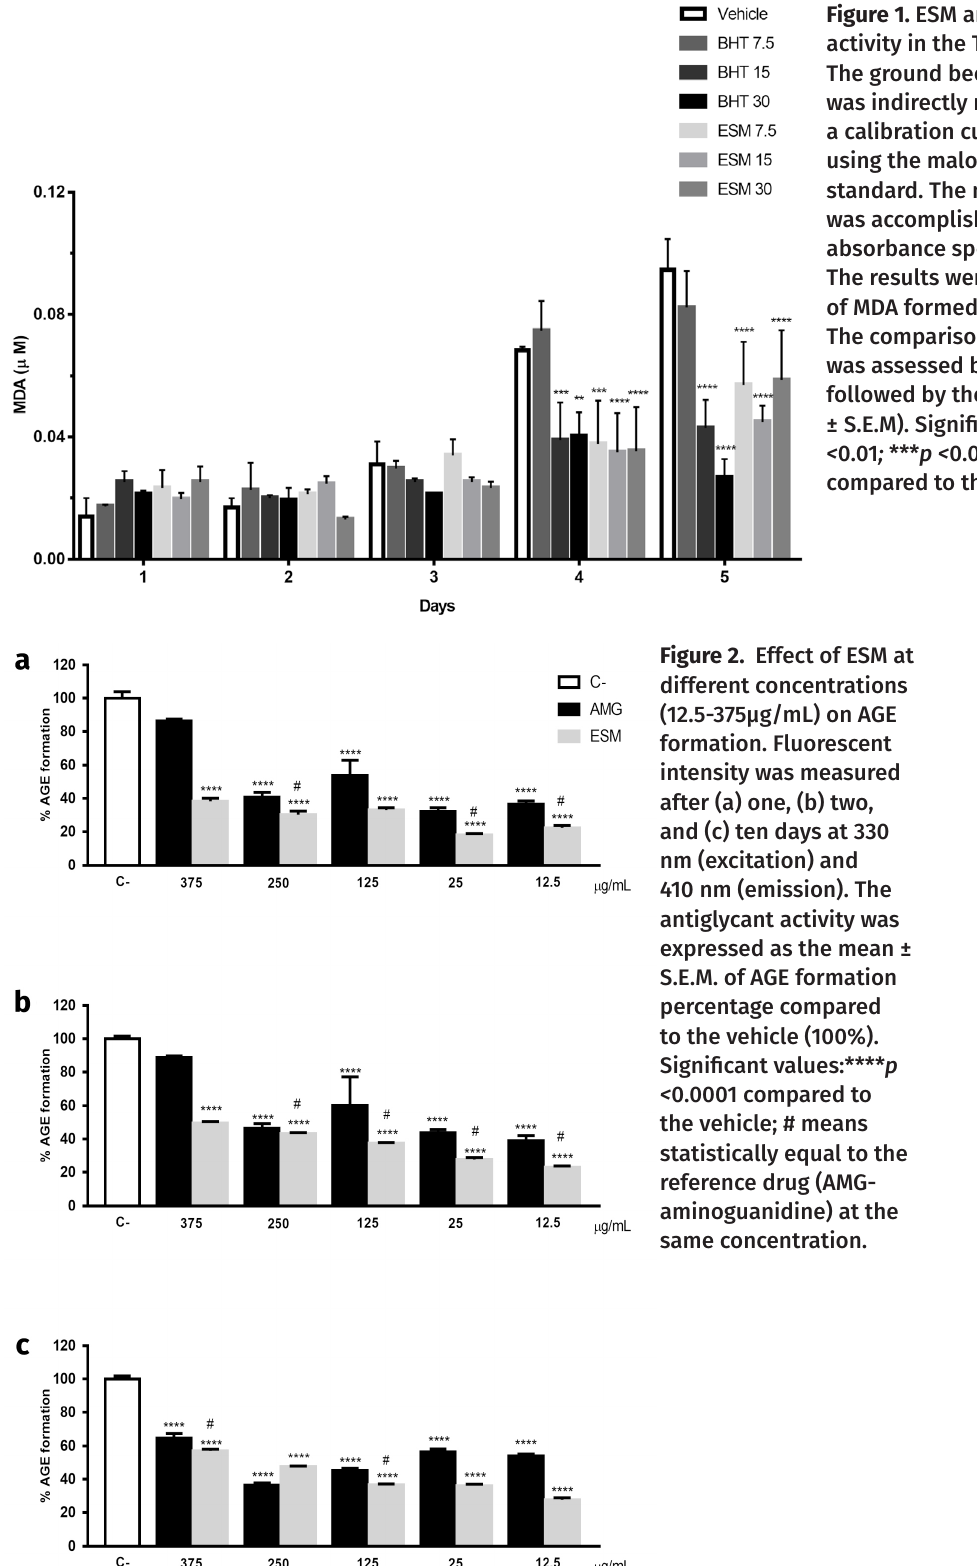
Figure 1. ESM antioxidant activity in the TBARS assay. The ground beef oxidation was indirectly measured by